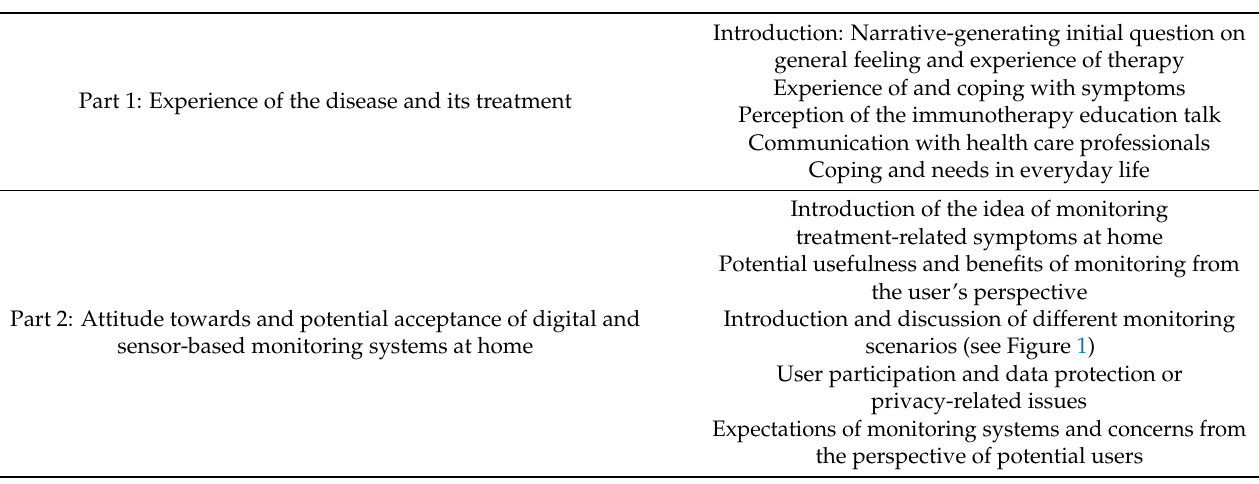
Figure 1. Digital and sensor-based scenarios for monitoring treatment-related symptoms of im- munotherapy in lung cancer at home.